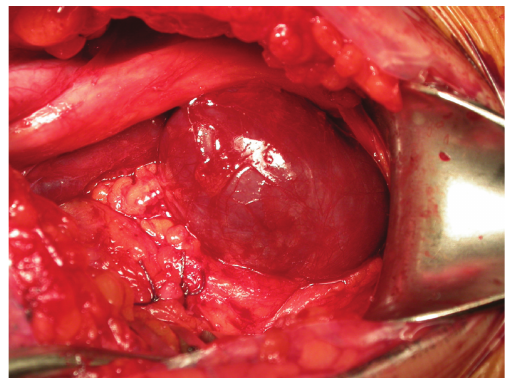
Figure 4: Surgical image showing the popliteal venous aneurysm.